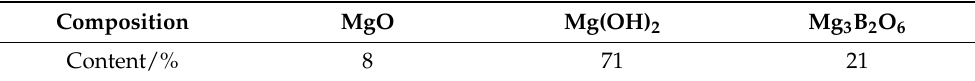
Table 2. XRD quantitative analysis of magnesium